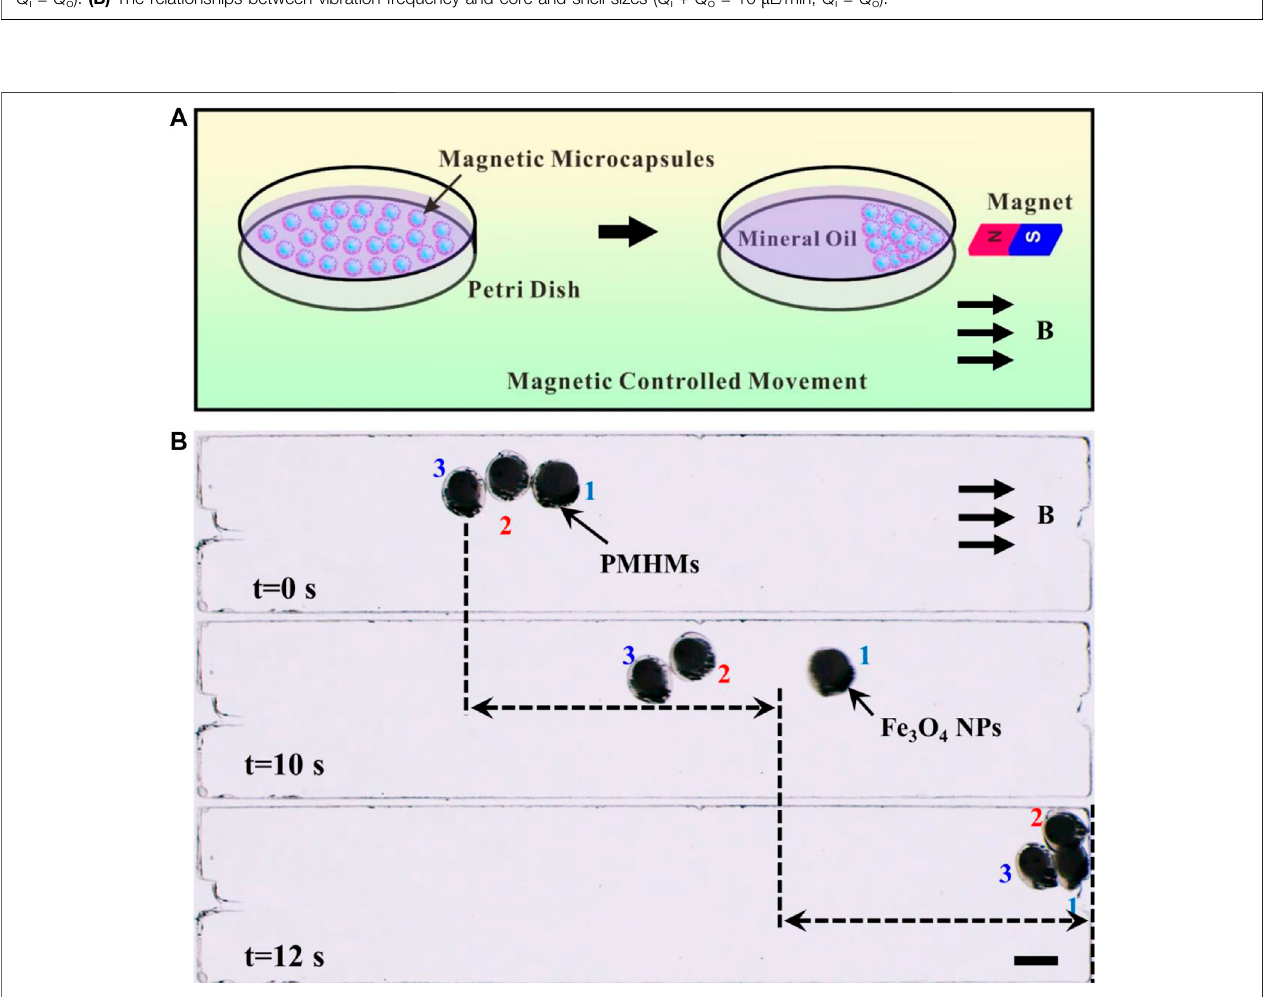
FIGURE4|(A) Schematicillustrationofmagnetic-guidedPMHMs. (B) ThepositionsofPMHMsat0,10,and12 sundertheactionofthemagnetic fi eld.Scalebar: 500 μ m.